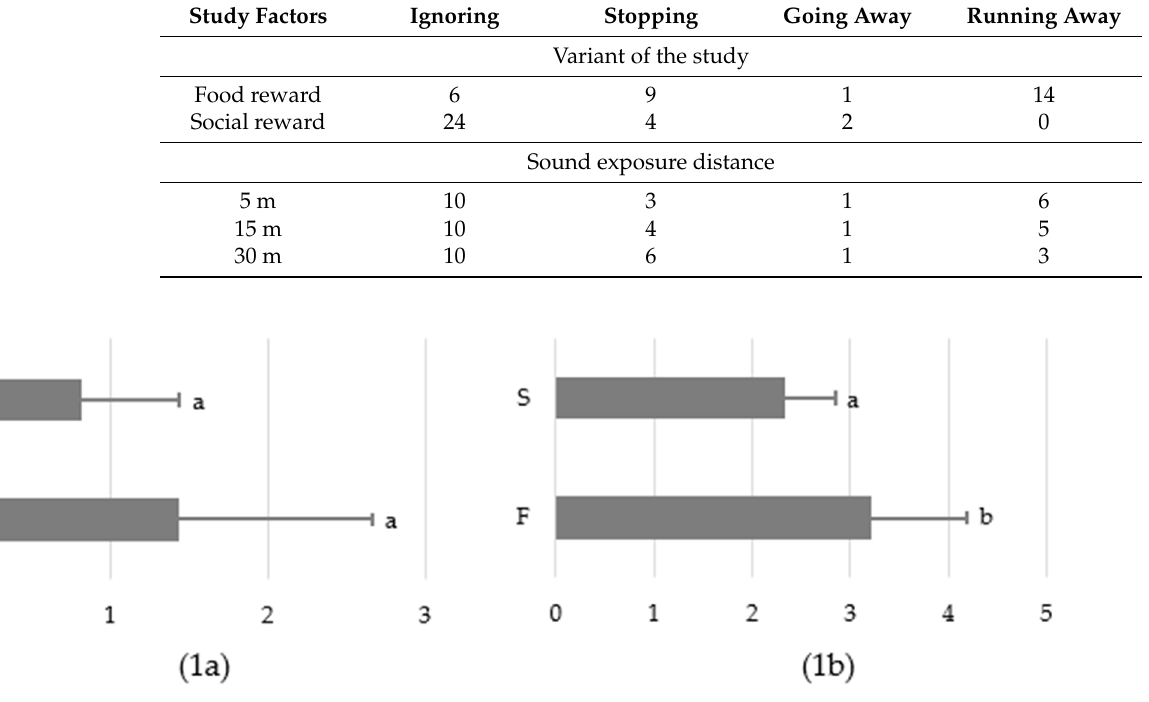
Table 4. Number of the horses that ignored, stopped, went or ran away after the sound application regarding the variant of the study and the sound exposure distance.